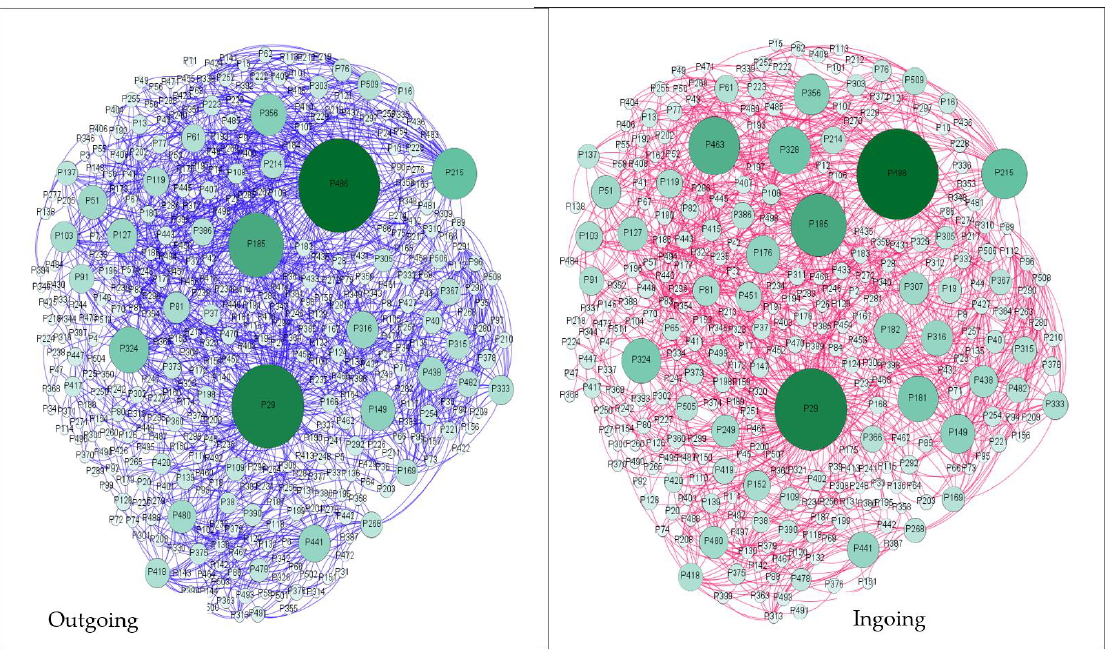
Figure 14. Outgoing and ingoing links. Table 16. Clusters of citation